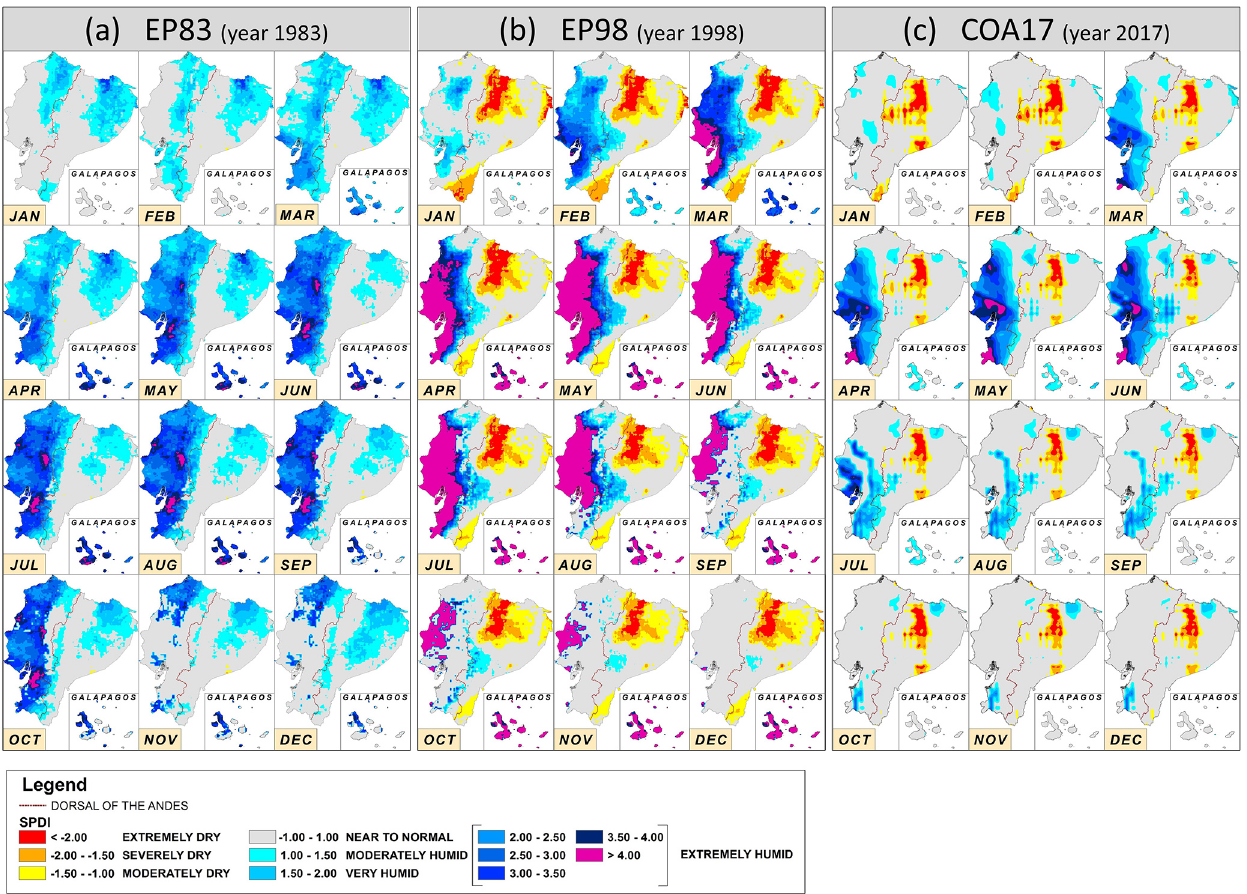
Figure 3. Spatial dynamics of Standardized Pluviometric Drought Index (SPDI) of Year 2 for the eastern Pacific mega-El Niño events EP83 (year 1983) (a) and EP98 (year 1998) (b) and the coastal El Niño COA17 (year 2017) (c) . SPDI categories are adapted from McKee et al. (1993).